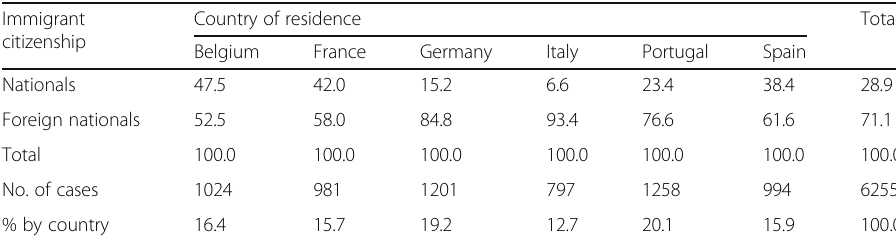
2012. Percentage values and number of